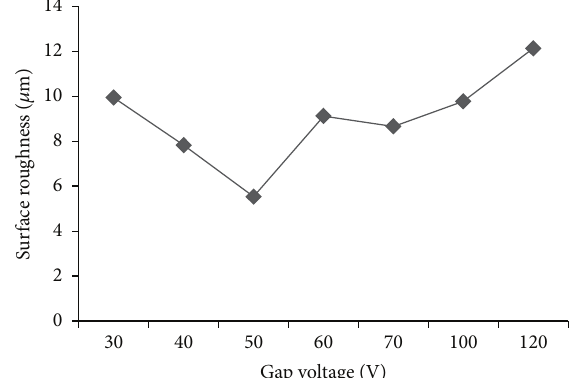
Figure 20: Influence of gap voltage on SR constant current 9Amp, pulse-on time 90 𝜇 s, and pulse-off time 90 𝜇